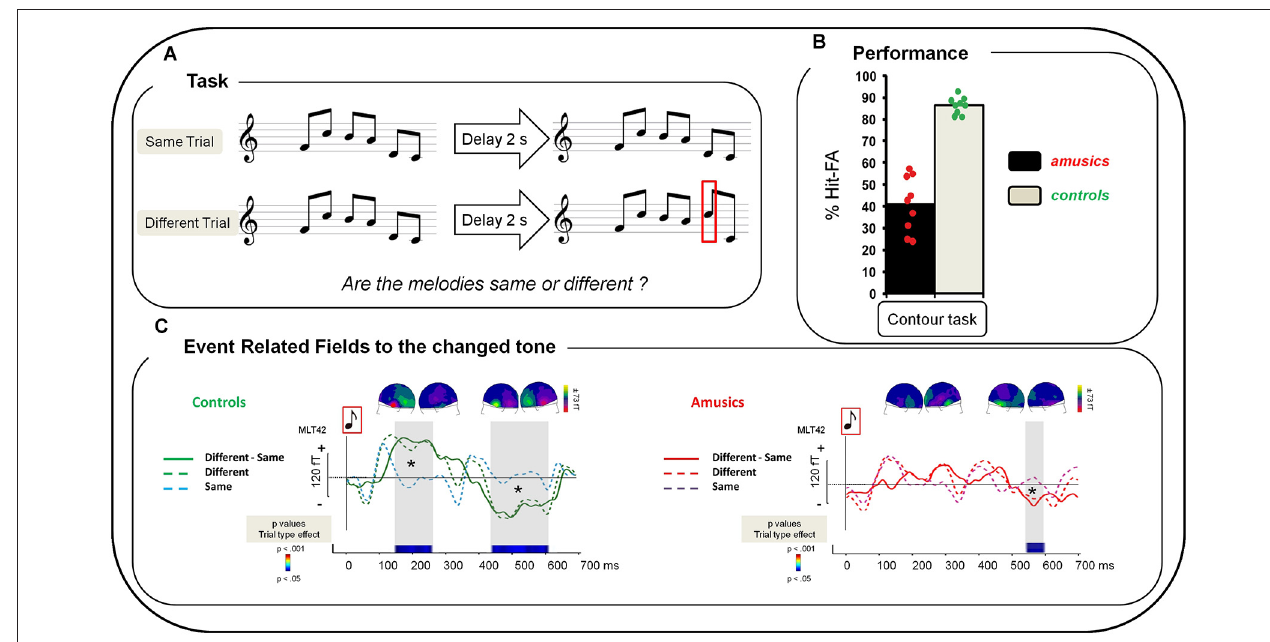
responses). Right: For amusics. Red dotted line: “Different” Trials, correct responses; purple dotted line: “Same” trials, correct responses; red plain line: “Difference Wave” (“Different” trials—“Same” trials for correct responses). Sensor plots correspond to the mean event-related fields (ERFs) of the “Difference Wave” in the 150–250 ms and the 400–600 ms time-windows for the change tone (average of all participants of each group).Two-sample t -tests were performed at each time sample on sensor amplitudes in the 0–700 time window in the two groups of participants. p -values are reported across time in the lower panel with blue for p < 0.05; green for p < 0.01; and red for p < 0.001. Note that only effects lasting longer than 15 ms were reported. See Albouy et al. (2013a) for